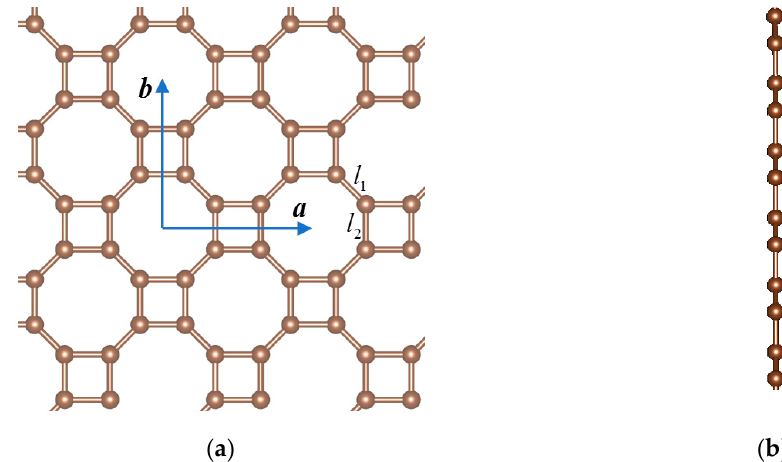
Figure 1. ( a ) Top view and ( b ) side view of the octagon ‐ structure carbon monolayer. The blue arrows a and b show two basis vectors of the unit cell which are along the x ‐ axis and y ‐ axis, respectively. The bond lengths l 1 and l 2 are the short and long edges of the octagons.